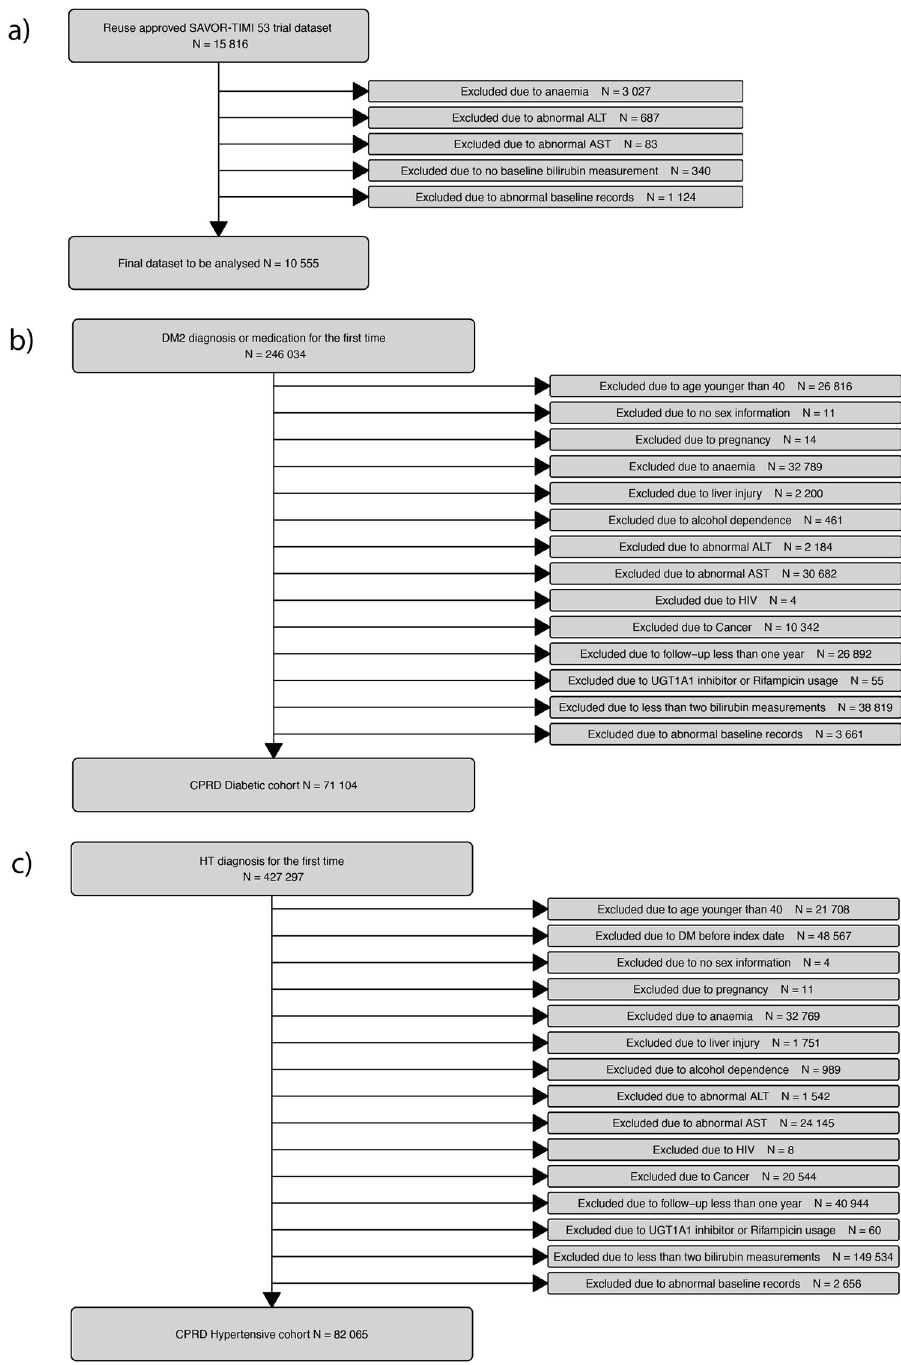
Fig 1. Flow diagram of patient disposition. The study cohorts are SAVOR (a subset of The Saxagliptin Assessment of Vascular Outcomes Recorded in Patients with Diabetes Mellitus-Thrombolysis in Myocardial Infarction 53) (Panels a), CPRD-DM2 (Type 2 diabetic cohort constructed from Clinical Practice Research Datalink) (Panels b), CPRD-DM2 (Hypertensive cohort constructed from Clinical Practice Research Datalink) (Panel c).